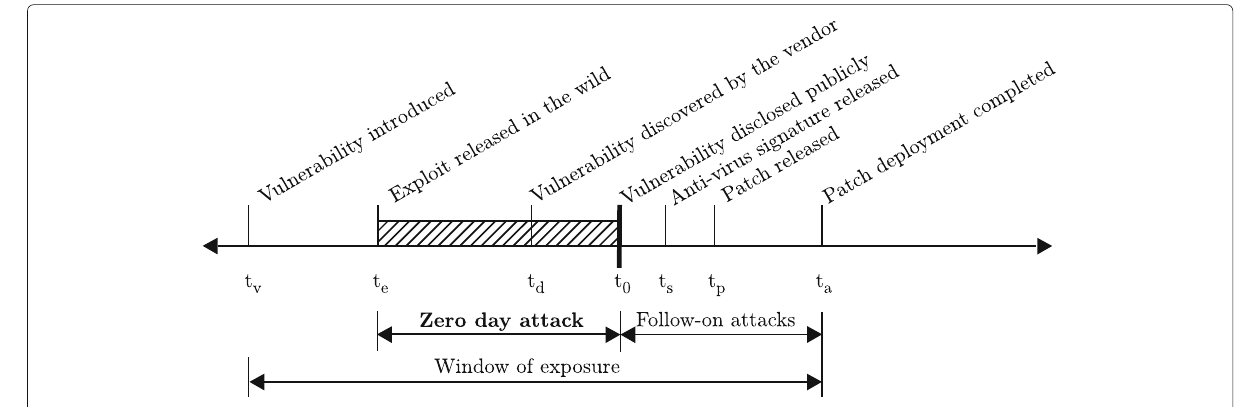
Fig. 1 The attack timeline for zero-day attacks